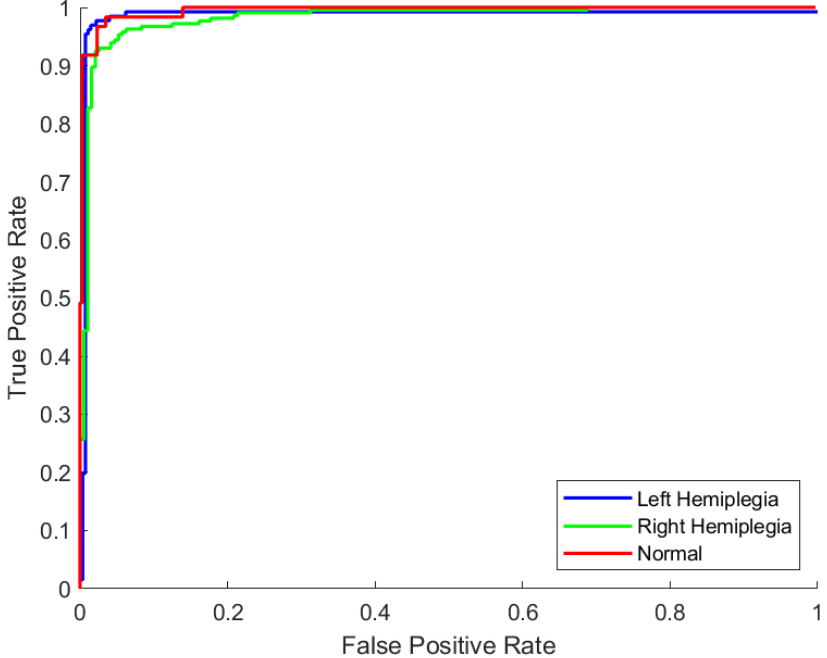
Figure 7. The ROC curves for each class. This figure depicts the ROC curves for left hemiplegic (blue color), right hemiplegic (green color), and normal subjects. All three curves are near the top left corner of the plot, which indicates a good-performing classifier.